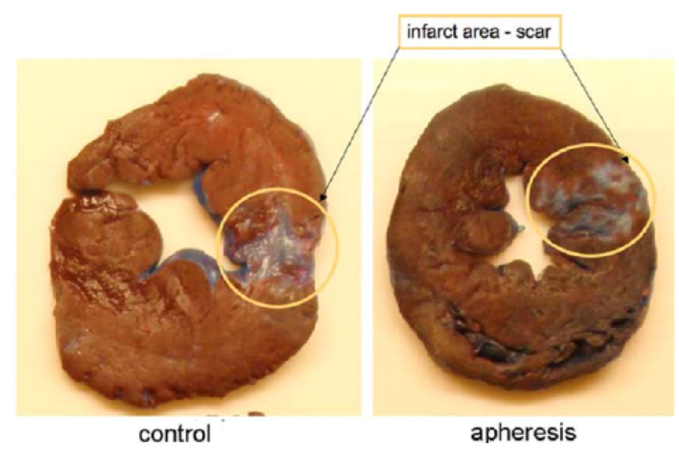
Figure 3. Porcine Heart Slices after AMI with and without CRP apheresis. Slices of the left ventricle 14 days after AMI. Slices were generated after an Evans Blue staining of the heart. Circles localize a characteristic transmural scar of a control animals (left) versus spotted scar morphology after CRP apheresis (right). Figure previously published and taken from [41] .